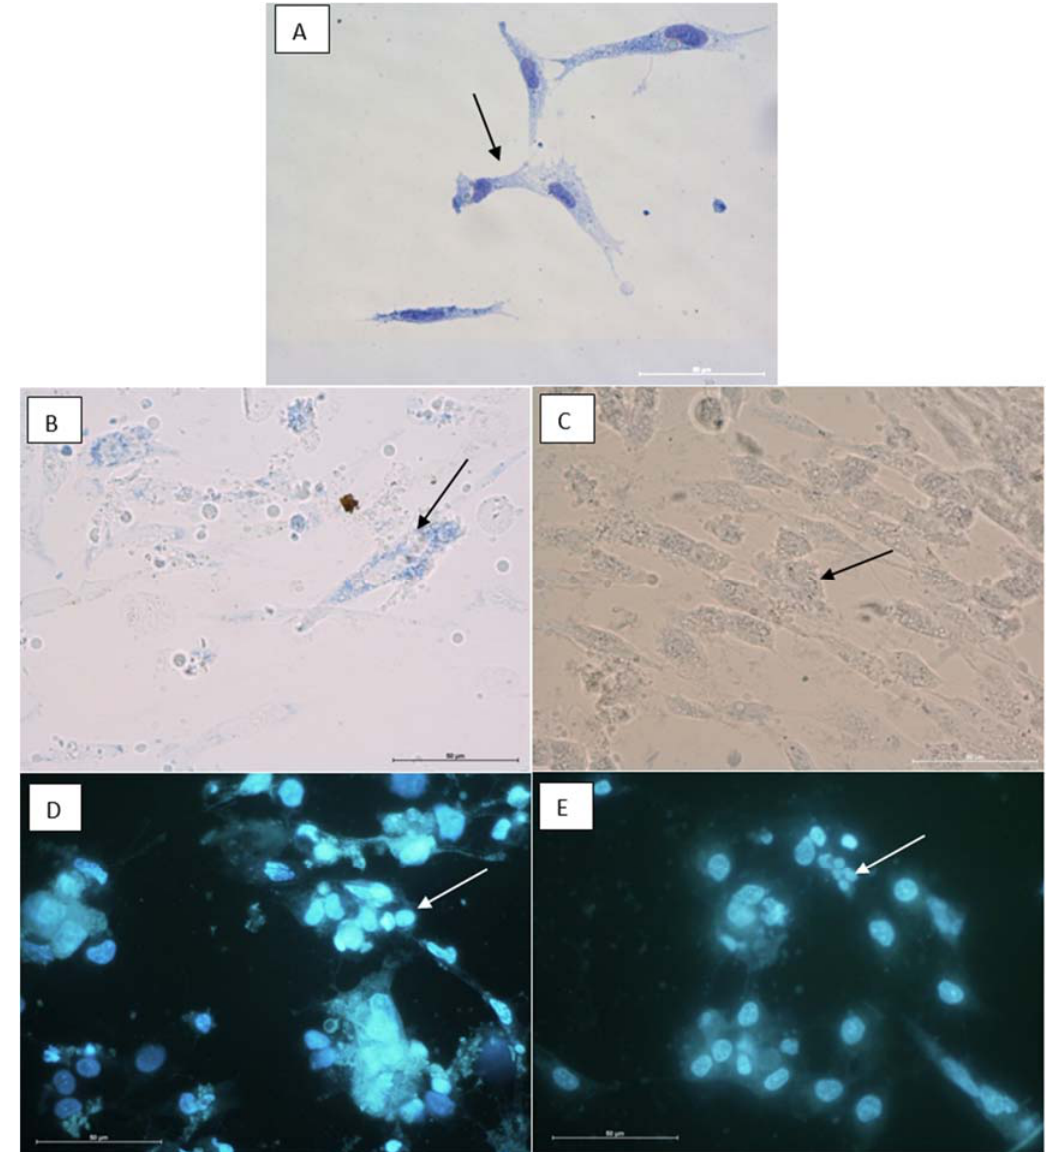
Figure 5. Changes in fibroblasts 45 min after administration of elderberry extract and cyanidin 3- O -glucoside. Control group ( A ), experimental group: EE in concentration 50 µg/mL ( B , D ), Cy 3-gluc in concentration 25 µg/mL ( C , E ). Note the change in cell shape (arrow). This process was more advanced in Cy 3-glu group than EE. Mitochondria are present in cells as small green/blue granules and their activity remains at the same level (arrow). In experimental group mitochondria are localized mainly around nucleus in contrast to control group, Mag × 200 scale bar represent = 50 µm.